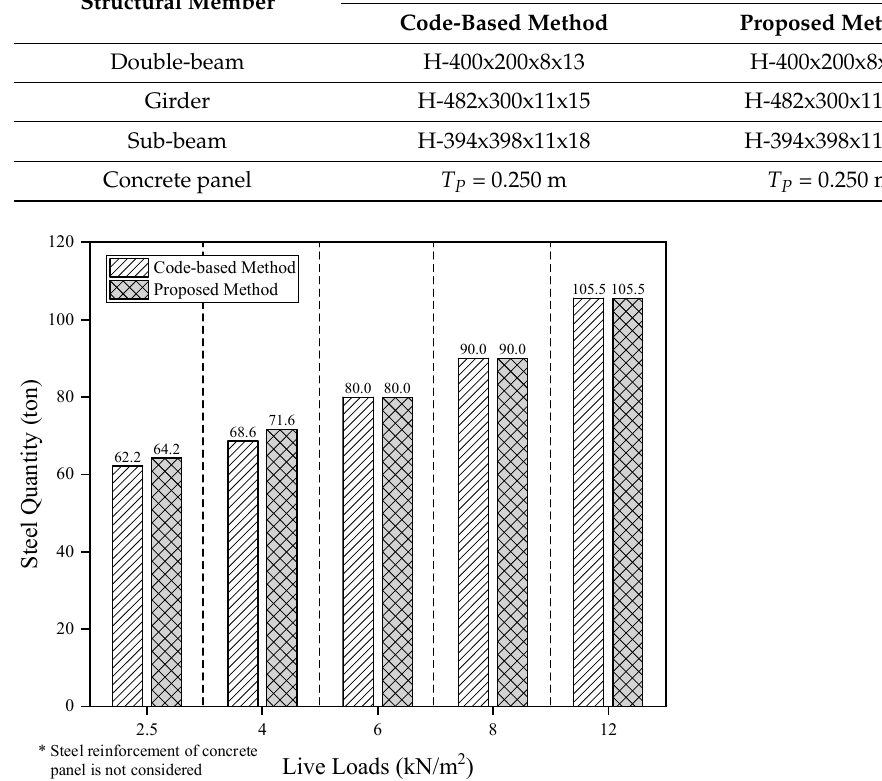
Figure 10. Comparison of designed steel quantity for steel double-beam system with concrete panel (DBO system) between code-based method and proposed method according to the level of live load.